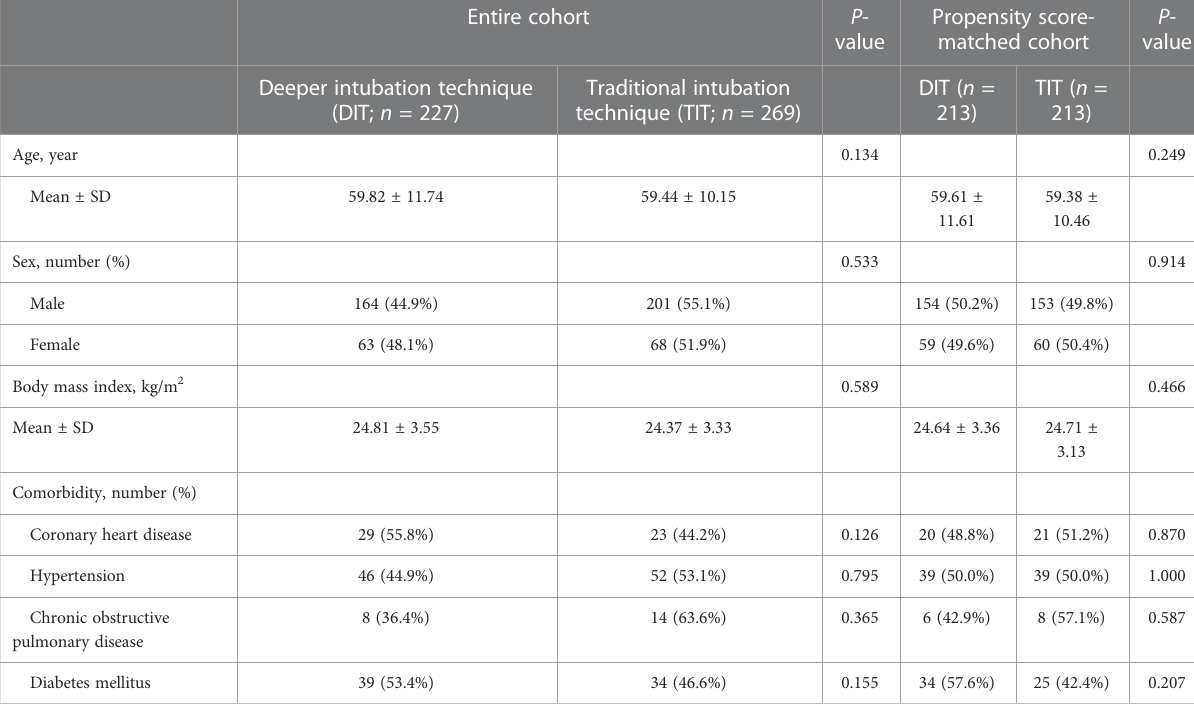
TABLE 1 Baseline clinical characteristics of patients between the two groups.